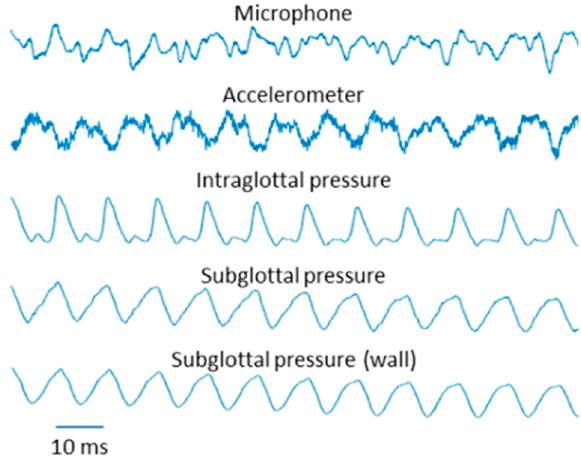
Figure 3. Example of synchronously recorded waveforms during self-sustained vocal fold oscillation of the whole-mount excised larynx, with ISP probe sensors measuring intraglottal pressure and subglottal pressure. Subglottal ‘wall’ pressure refers to the second pressure sensor 6 cm below the glottis.